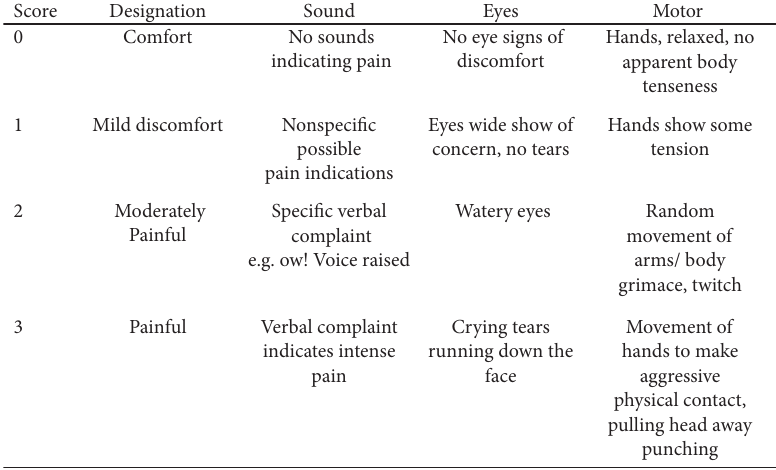
Figure 3: SEM scale for pain assessment from child’s behavior (score